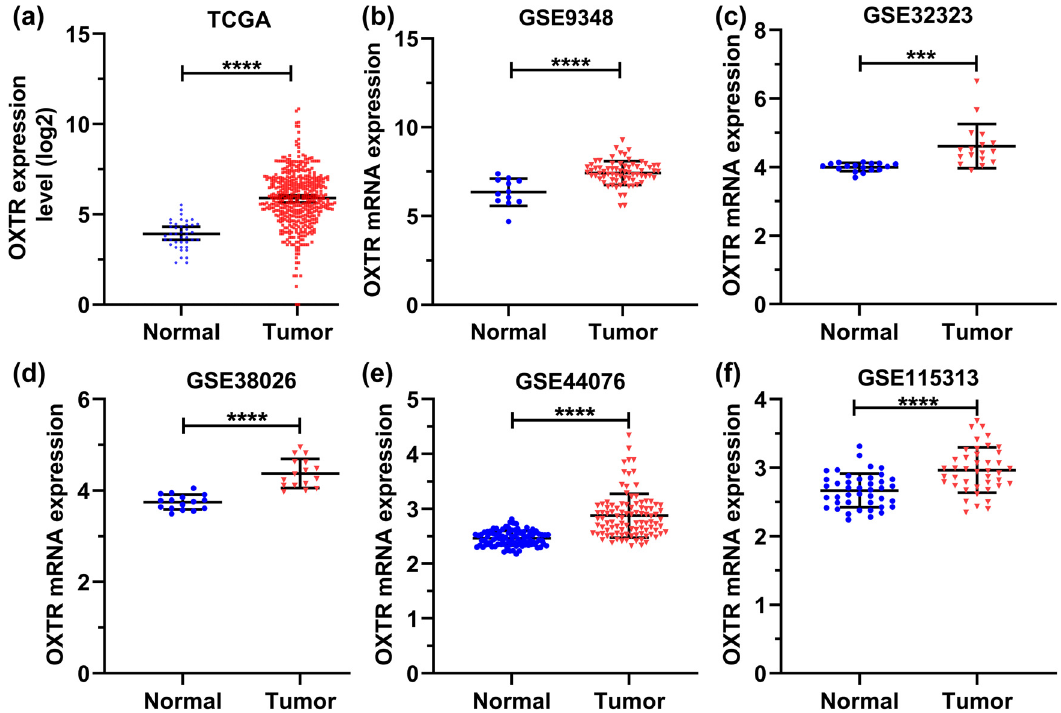
Figure 2: OXTR mRNA level is high in COAD patients from six datasets. ( a – f ) GraphPad Prism 8 was used to analyze the expression of OXTR in COAD samples from TCGA ( a ) , GSE9348 ( b ) , GSE32323 ( c ) , GSE38026 ( d ) , GSE44076 ( e ) , and GSE115313 ( f ) databases. ***: p < 0.001; ****: p <